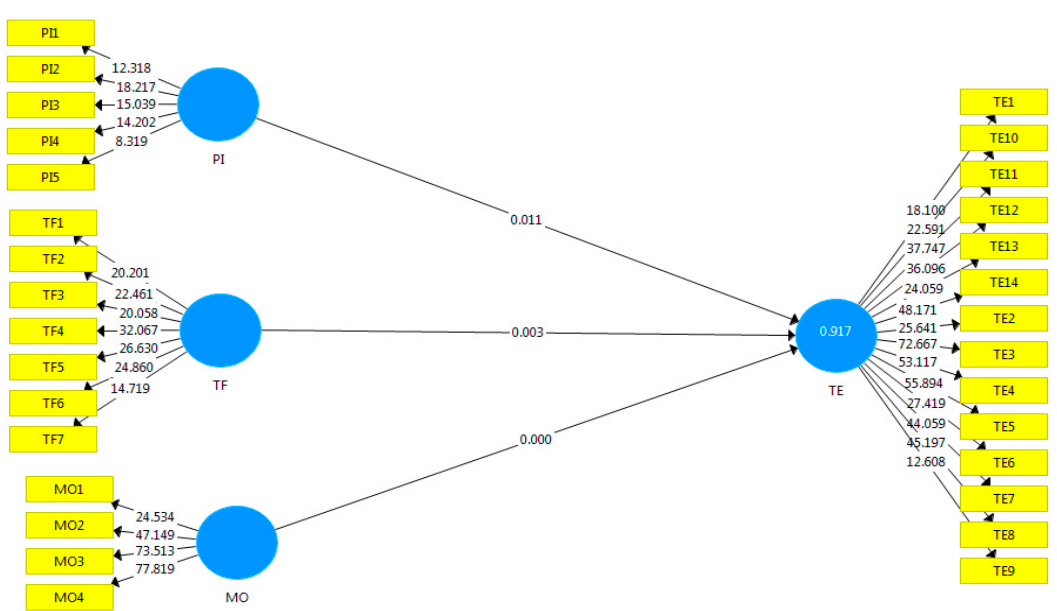
Figure 3. Structural model for direct effect ( p -values).